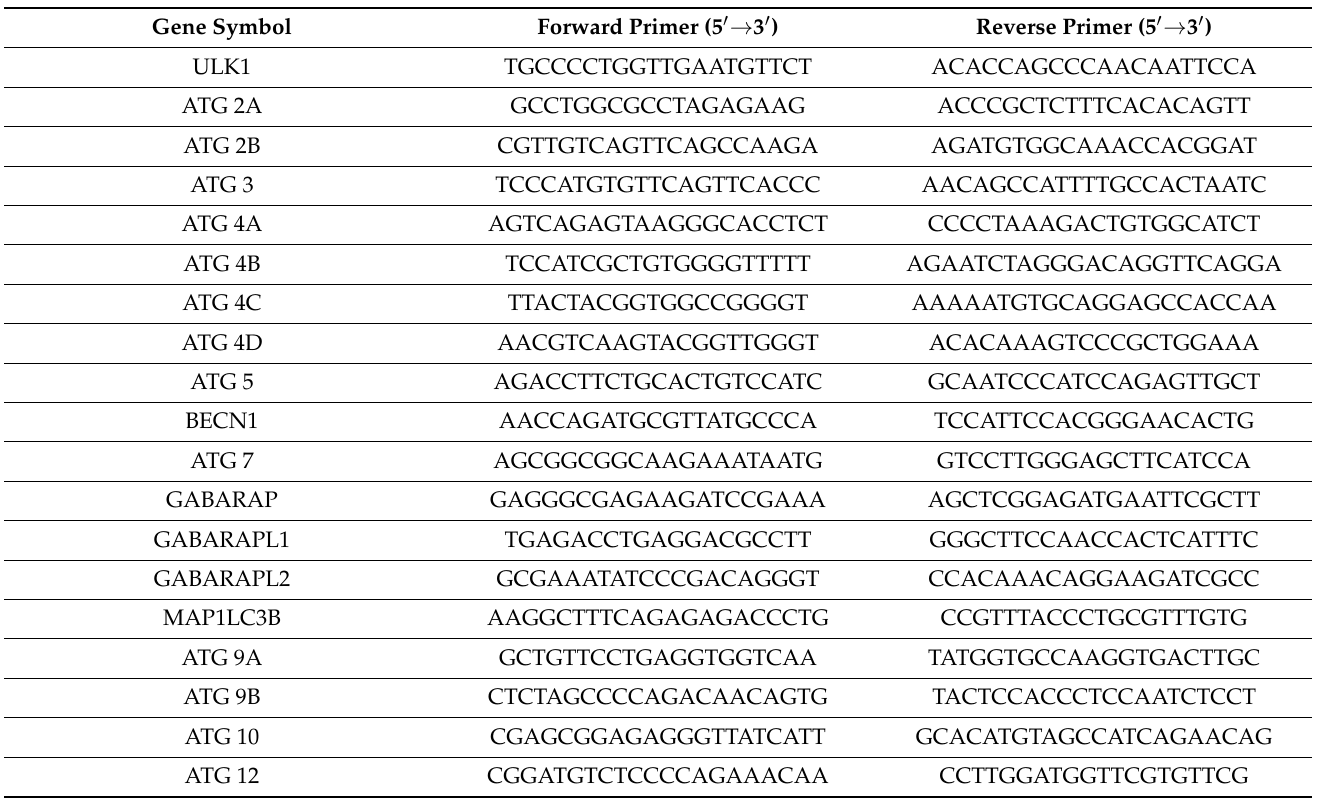
Table 1. Primer sequences for the real-time polymerase chain reaction quantification of human autophagy-related gene transcripts. Gene